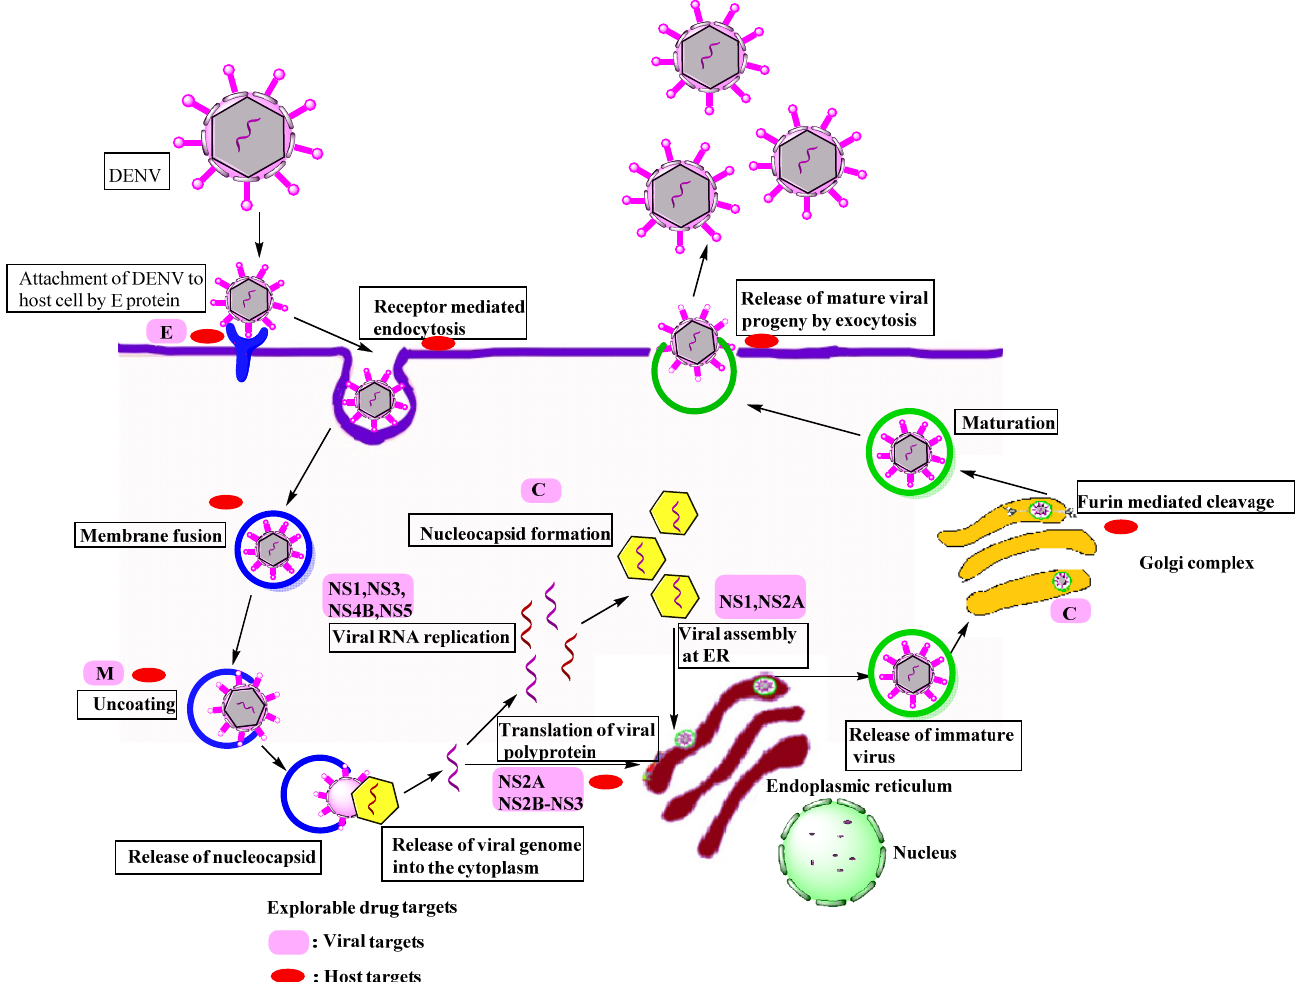
Figure 2. Schematic diagrams showing the life cycle of the DENV in a host cell. The discharged viral RNA undergoes two processes in the cell: translation and viral genome replication. The viral RNA functions similarly to the host mRNA. The lack of a poly-A tail in viral RNA is the most noticeable distinction from host mRNA. The translation of cellular mRNA differs from that of viral mRNA. As a result, the genome is processed into a polypeptide chain in the ribosome present on ER, where translation occurs [11].